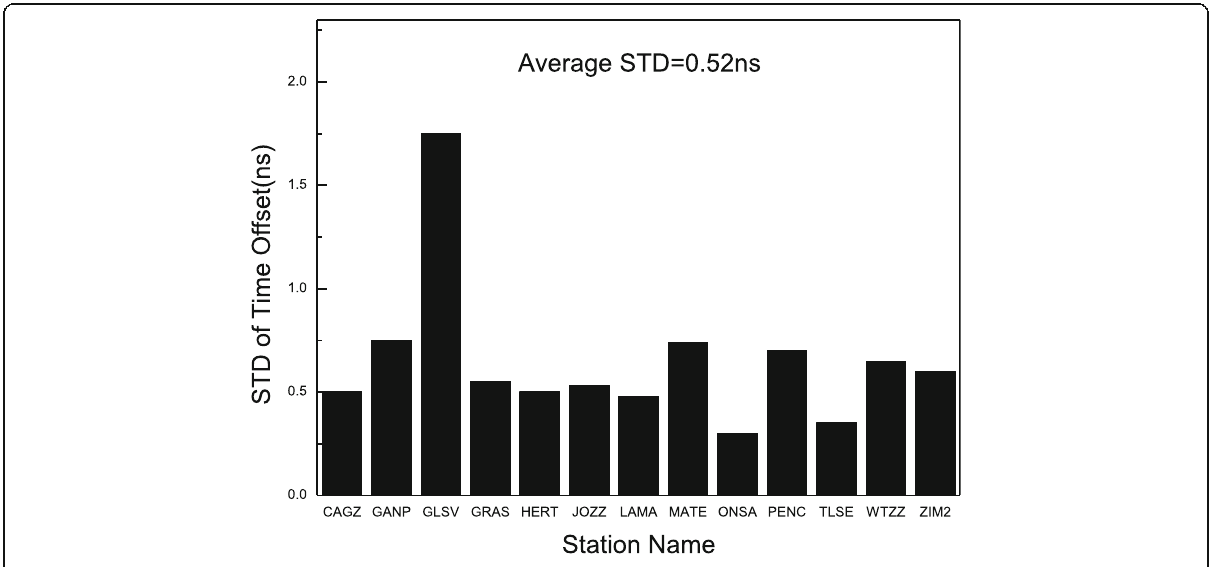
Fig. 10 Standard deviation statistics for time difference sequences of different stations